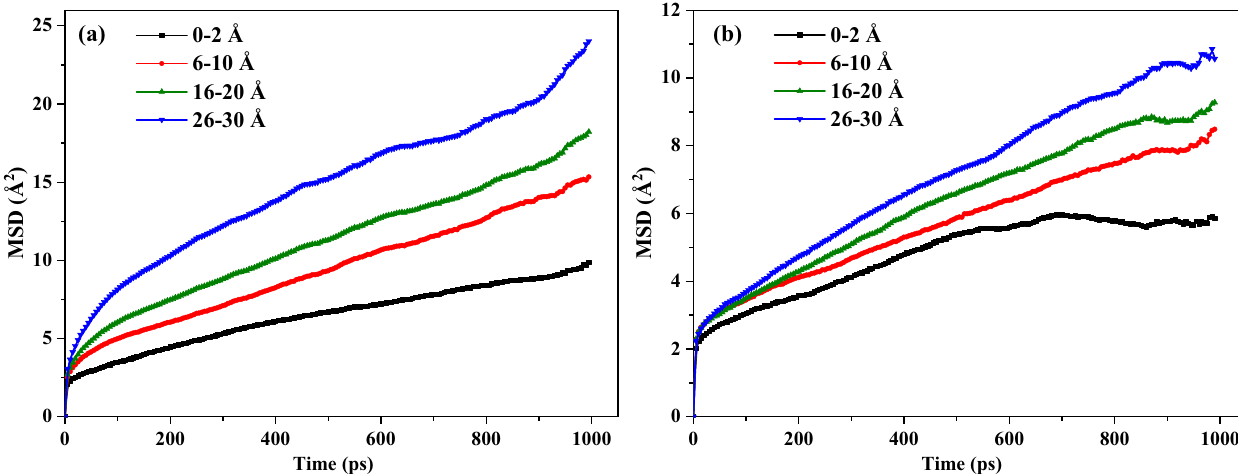
Fig. 6 MSDs of PDMS chains at different distances along the Z-direction of the silica-PDMS interface in different models as a function of simulation time. a the interface Model 1 system, and b the interface Model 4 system.